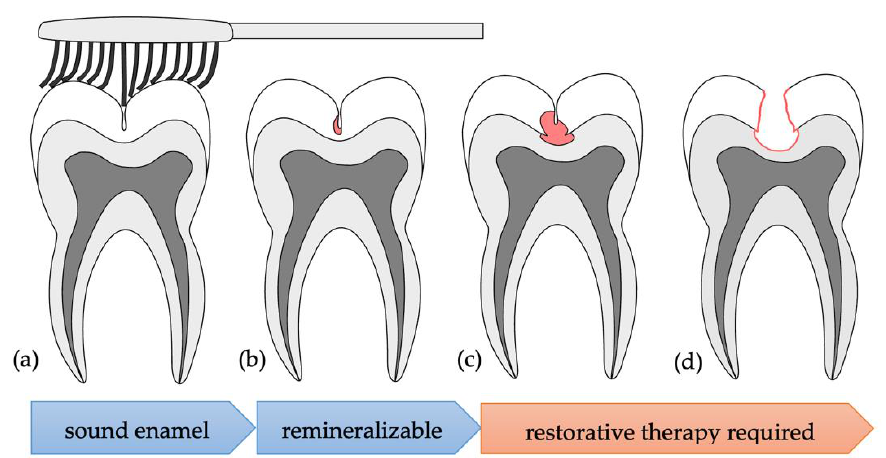
Figure 1. ( a ) The fissure is a predilection site for occlusal caries as its narrow anatomy